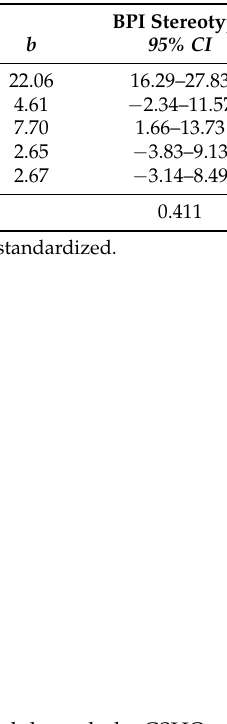
Figure 2. The relationship between sleep disorders (measured through the CSHQ questionnaire) and aggressive behaviors (measured through the BPI questionnaire) is moderated by mealtime behaviors (measured through the BAMBI